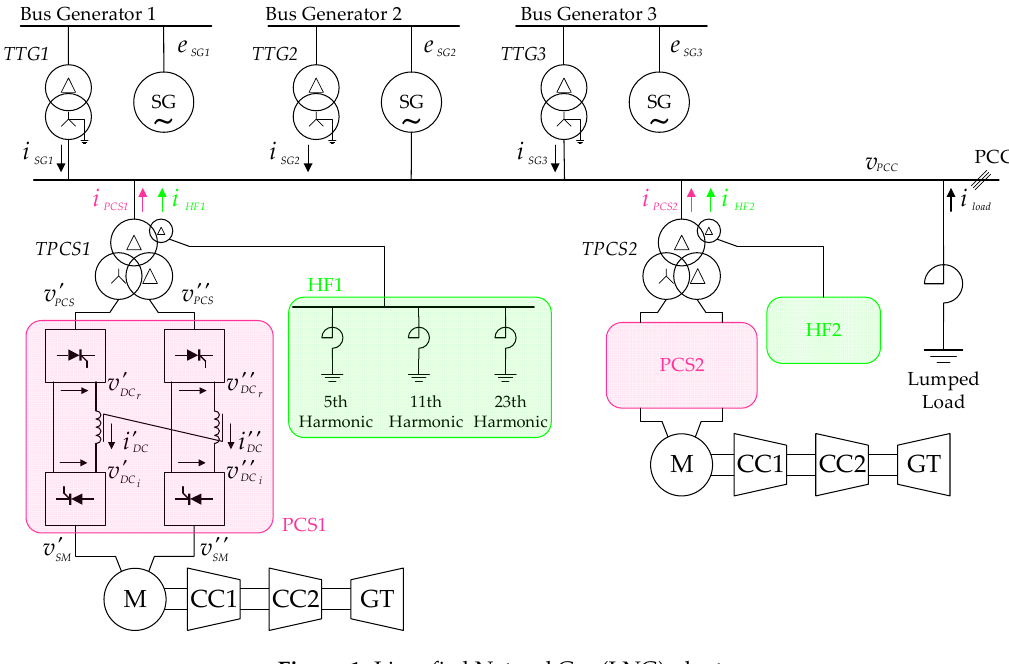
Figure 1. Liquefied Natural Gas (LNG) plant.